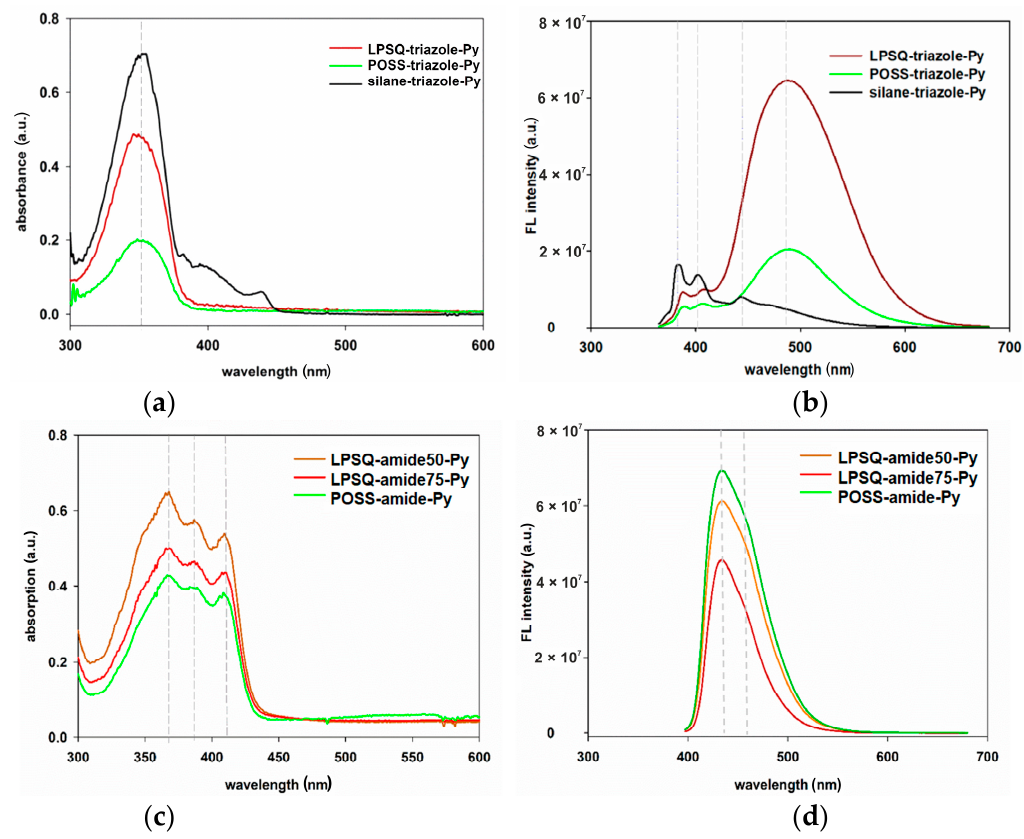
Figure 9. Comparison of ( a ) absorption and ( b ) FL emission spectra ( λ ex = 350 nm) of LPSQ, POSS, silane-triazole (c Py = 10 − 6 mol / L in THF), ( c ) absorption and ( d ) FL emission spectra ( λ ex = 387 nm) of LPSQ-amide50-Py, LPSQ-amide75-Py and POSS-amide-Py (c Py = 10 − 6 mol / L in